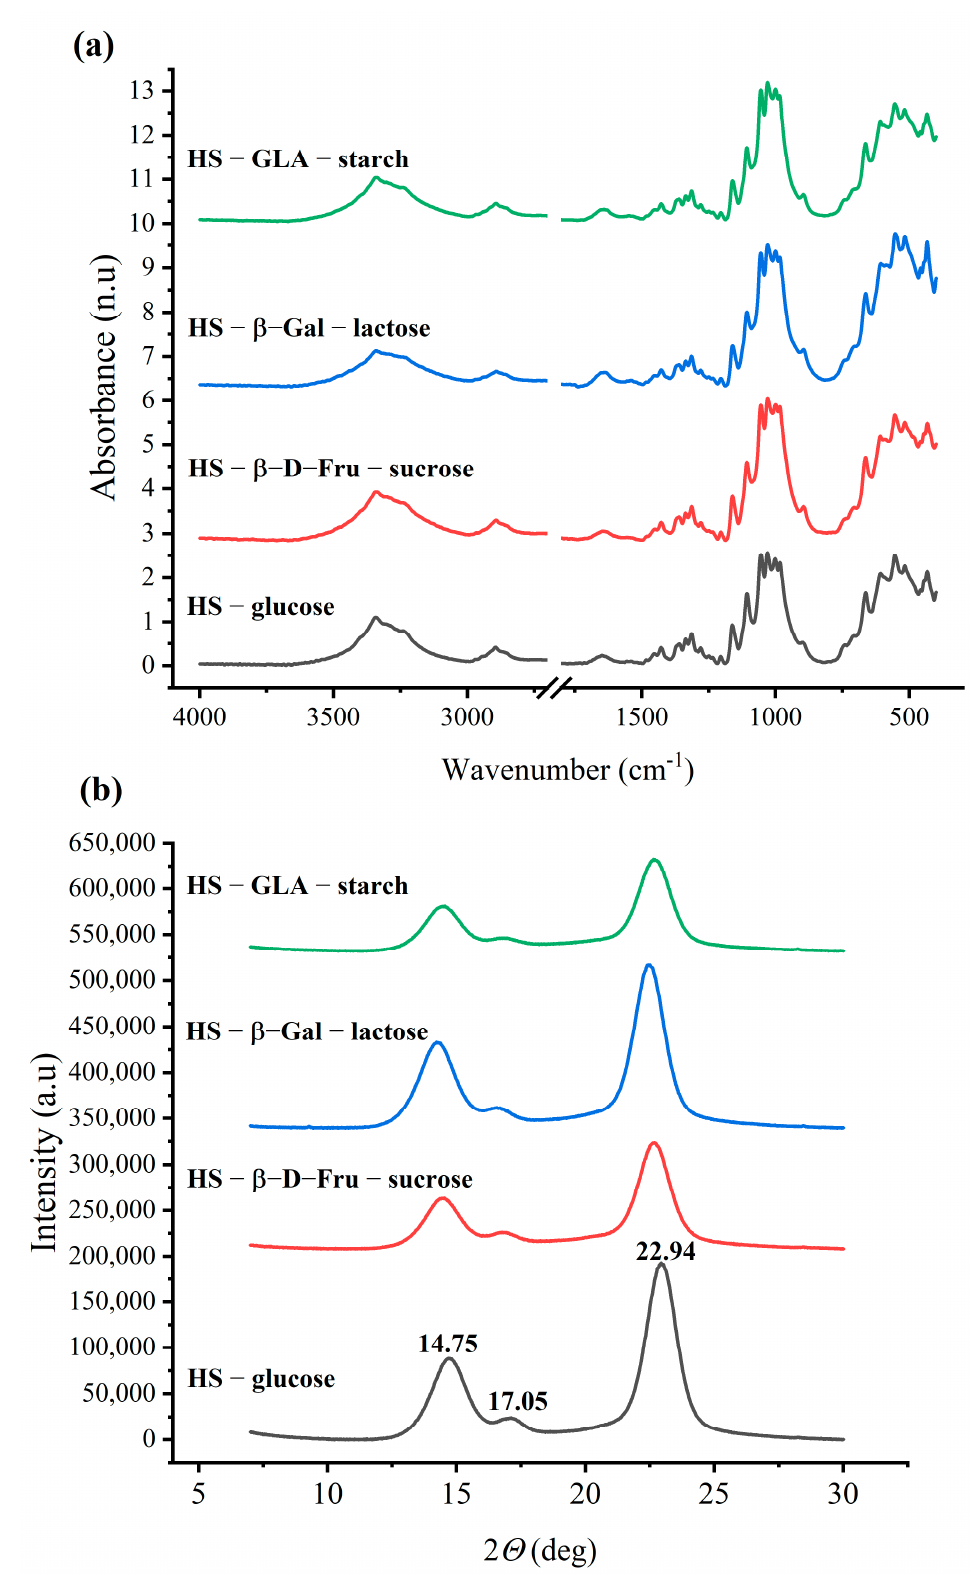
Figure 4. The representative ATR-FTIR spectra ( a ) and XRD diffractograms ( b ) of bacterial cellulose obtained from cultures with enzymatic conversion of sucrose, lactose, and starch to accessible carbon sources. The spectra from analysis BC samples obtained from modified media with the highest enzyme units amounts.